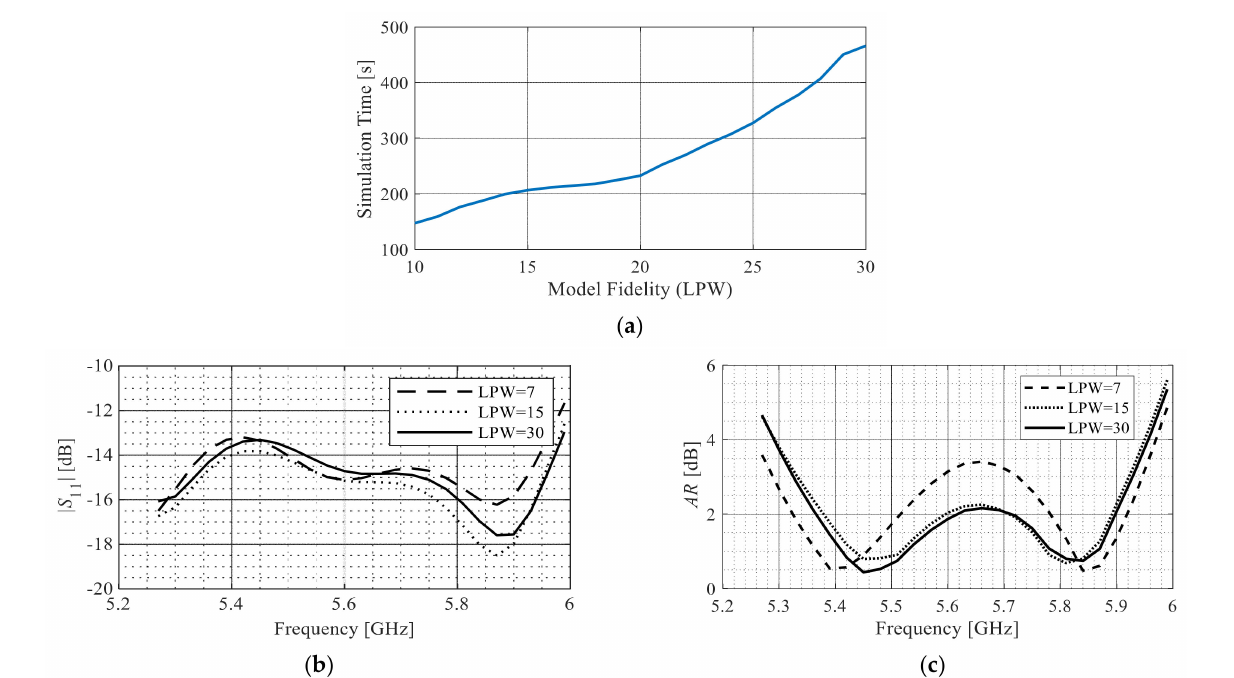
Figure 21. CP antenna (geometry shown in Figure 25) ( a ); EM responses for various model fidelities: ( a ) dependence of the simulation time on the model discretization density, ( b ) reflection responses and ( c ) axial ratio for various fidelity levels.